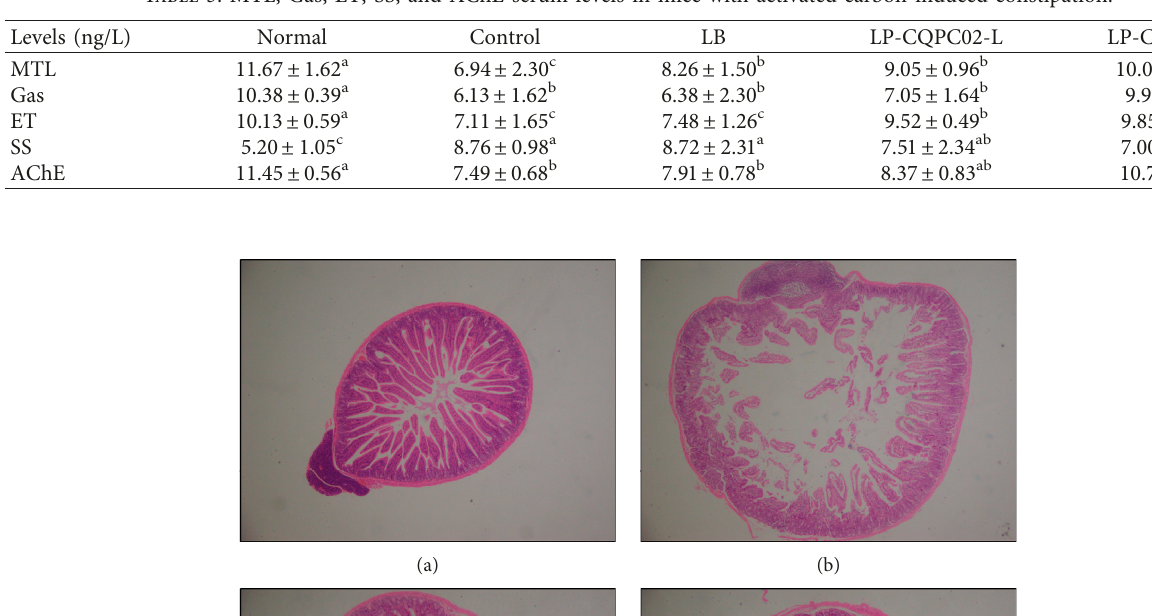
The values presented are the mean ± standard deviation. a–e The mean values with different letters in the same row are significantly different ( p < 0.05) according to Duncan’s multiple-range test. LB: Lactobacillus delbrueckii subsp. bulgaricus (1.0 × 10 9 CFU/kg b.w. gavage); LP-CQPC02-L: Lactobacillus